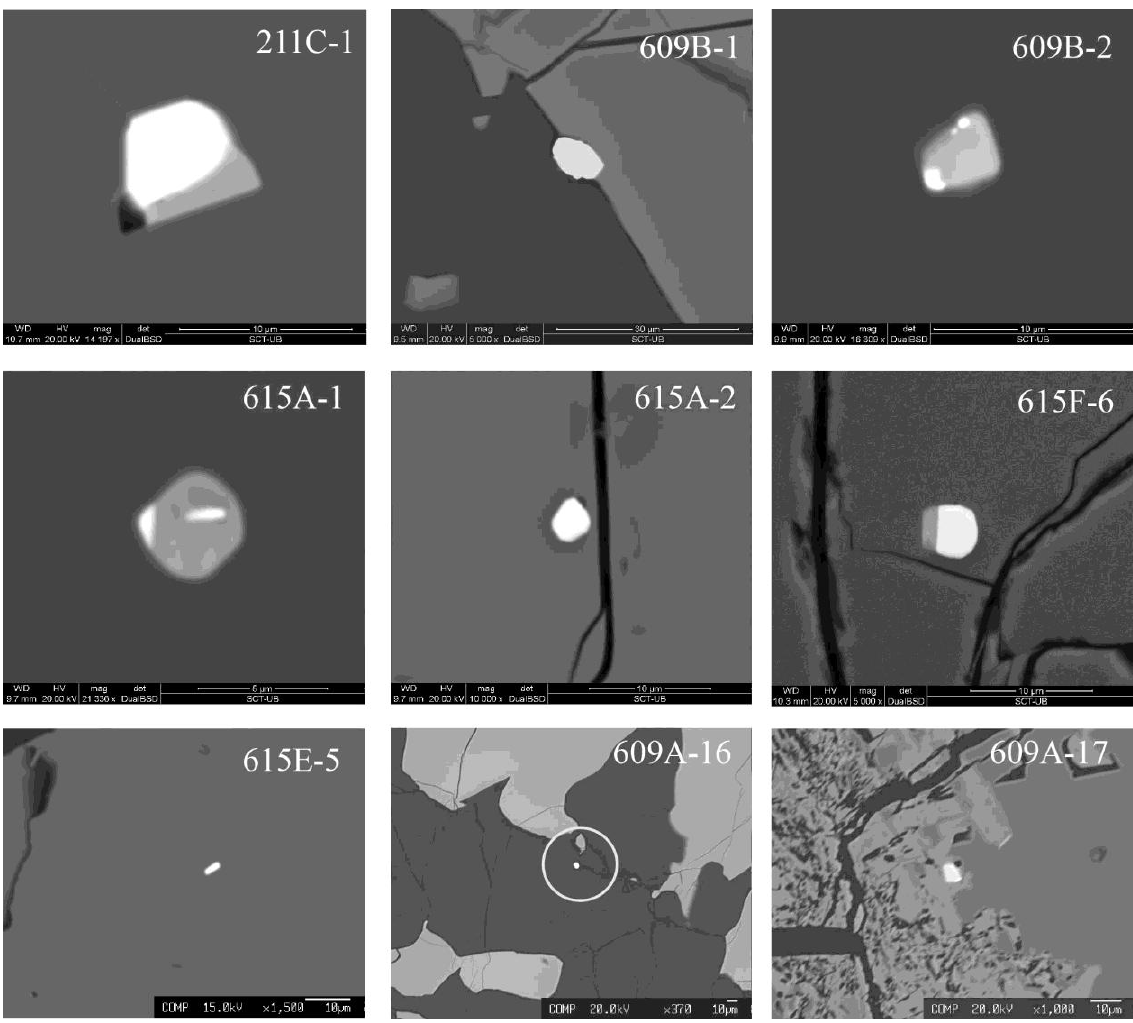
Figure 8. Paragenetic assemblages of PGM associated with the CHR-1 chromitite